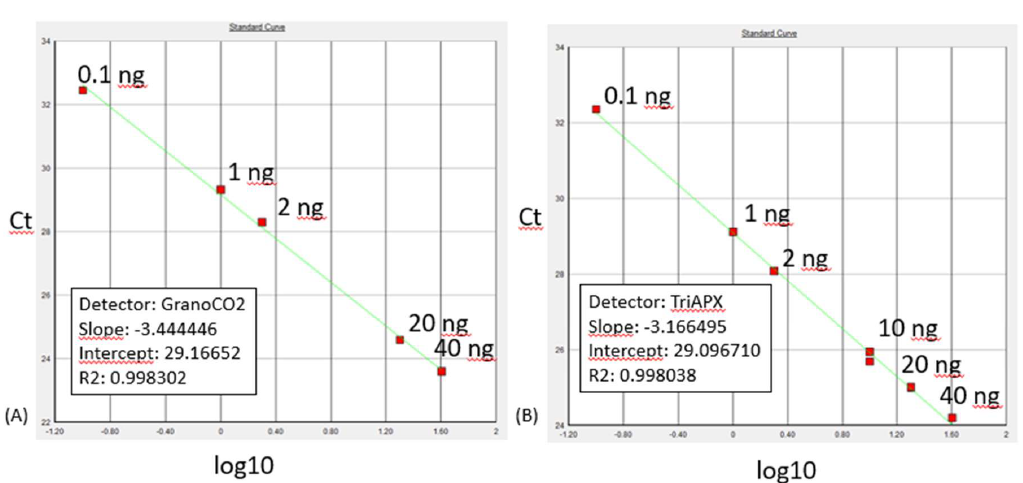
Figure 1. qPCR standard curves obtained after amplification of the DNA dilutions reported in the graph with GranoCO2 primers ( A ) and with TriAPX primers ( B ).